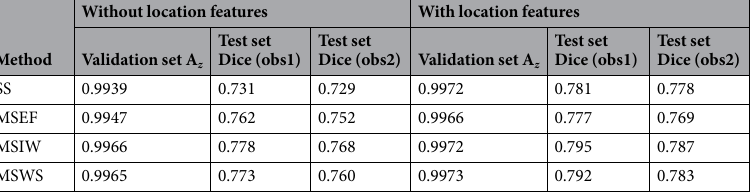
Table 2. Performance comparison of different CNN architectures based on validation set A z and test set Dice score considering observer 1 and observer 2 as the reference standard.